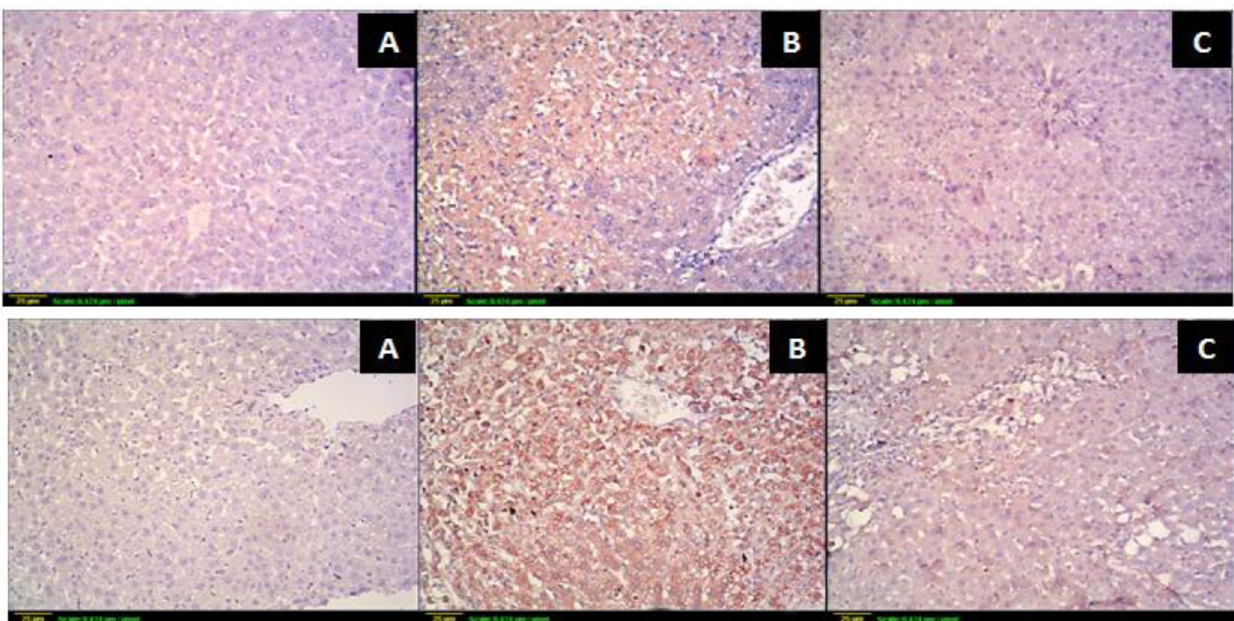
Fig 3. Immunohistochemical effect of P . niruri AE (100 mg kg -1 day -1 ) on COX-2 and iNOS expression. Expression of COX-2 (Higher panel) and iNOS (lower pannel) by immunohistochemical staining (x100); (A): control; (B) CCl 4 ; (C) CCl 4 + 100 mg kg -1 day -1 P . niruri AE.